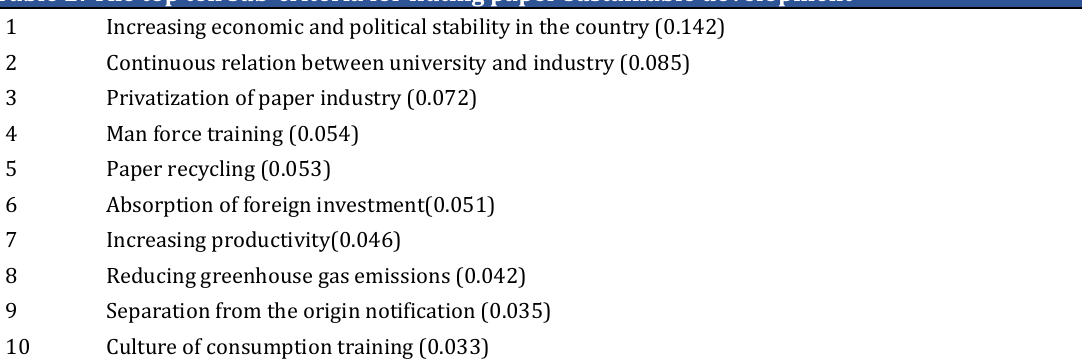
Table 2: The top ten sub-criteria for fluting paper sustainable